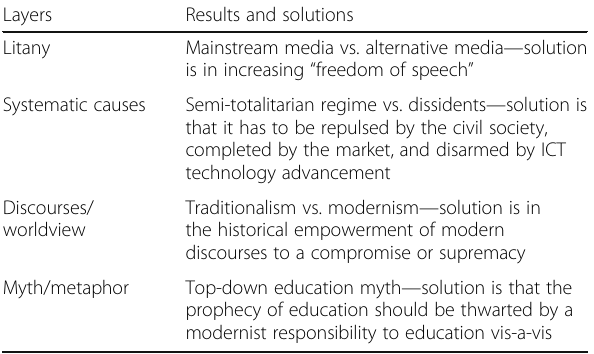
Table 3 Findings and solutions in each analysis layer